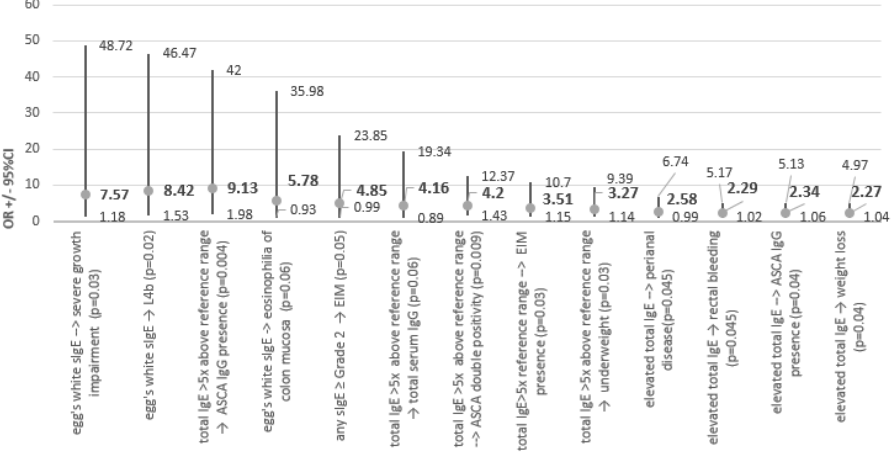
Figure 3. Crohn’s disease—OR.